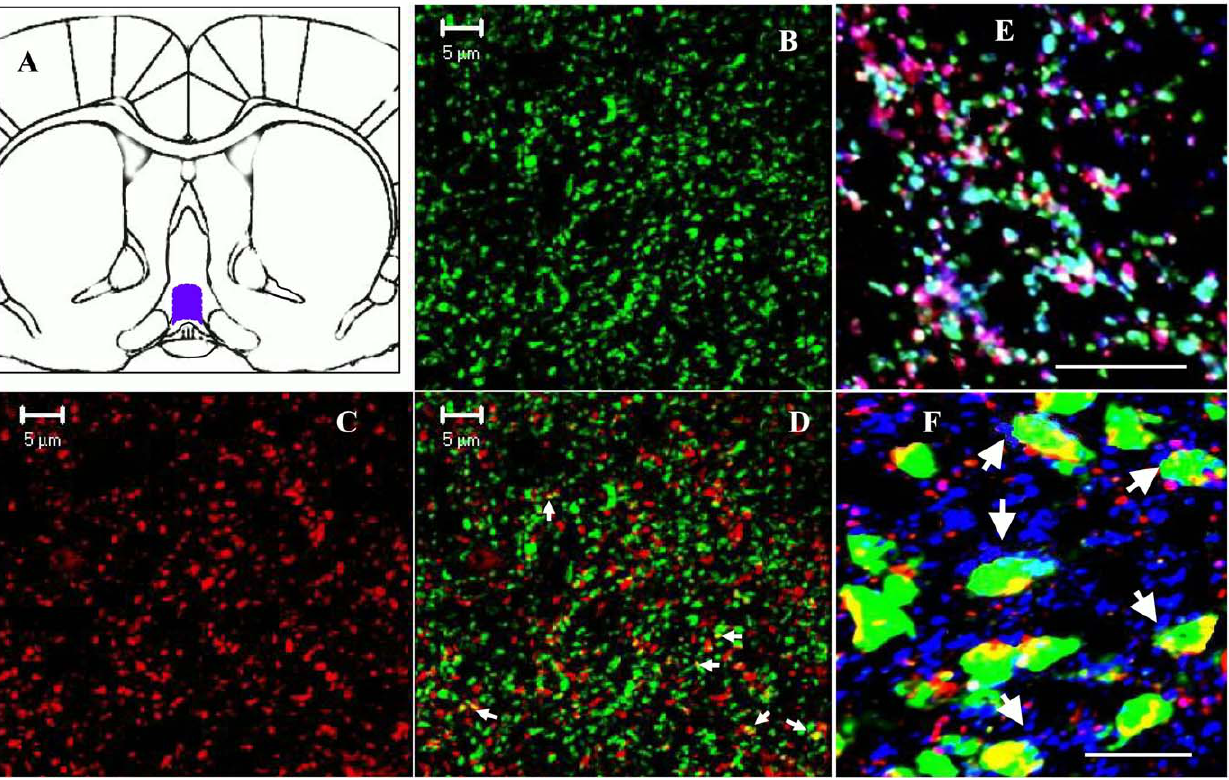
Figure 1. Expression of VGAT and VGLUT2 synaptic proteins in the rPOA of the proestrous female rat. Figure 1A shows a schematic diagram of rat brain in coronal plane highlighting the POA region. Figures 1 B and C show 3D confocal images of VGLUT2 (green) and VGAT (red) obtained using 63X objective lens with additional 3X digital zoom. Both VGLUT2 and VGAT show punctate staining characteristics of presynaptic terminals. Figure 1D shows a merged (colocalized) image which indicates that while both VGLUT2 and VGAT proteins are highly expressed in the same region, only a small percentage ( , 10%) of them show colocalization (white arrows) with each other. Figure 1E shows an enlarged view of VGAT (red) and VGLUT 2 (green) colocalization ( . 90%) with synaptophysin (blue) in the POA region. Figure 1F shows that almost all ER a positive (green) neurons show colocalization/co-expression (white arrows) of VGAT (red), VGLUT2 (blue) in the AVPV region. Scale bars represent 5 m m in Figure 1 B-D and 10 m m in Figure 1 E-F.